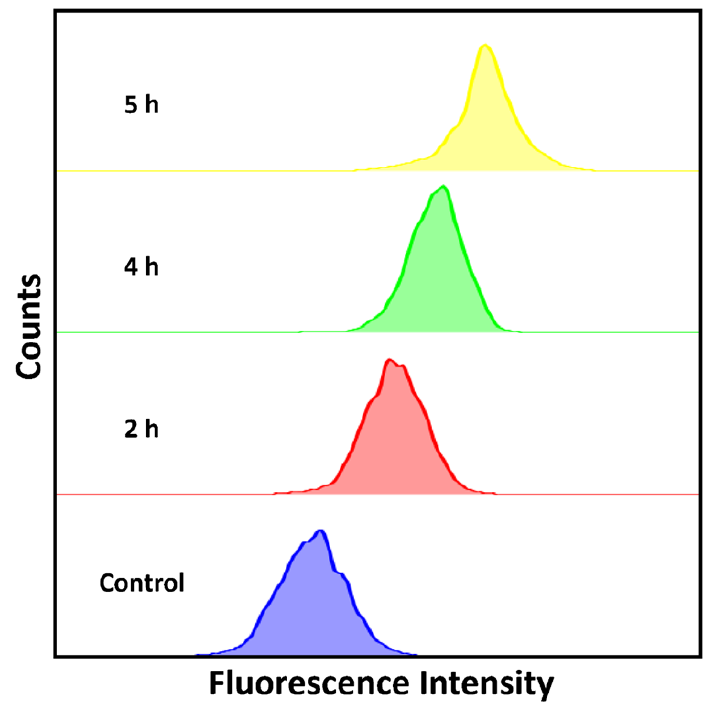
Figure 2. Flow cytometry analysis of cellular uptake of the polymer–bufalin conjugate P2 for 2, 4, and 5 h in HepG2 cells.